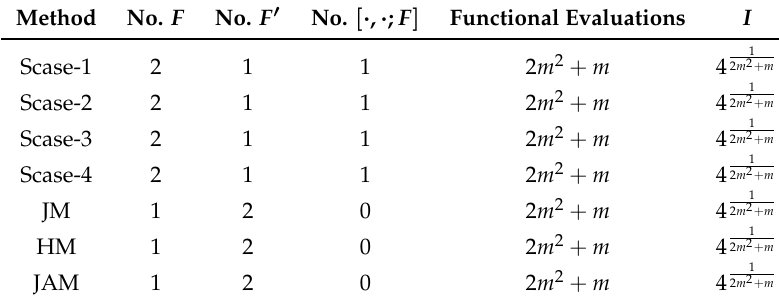
Table 2. Efficiency index for different